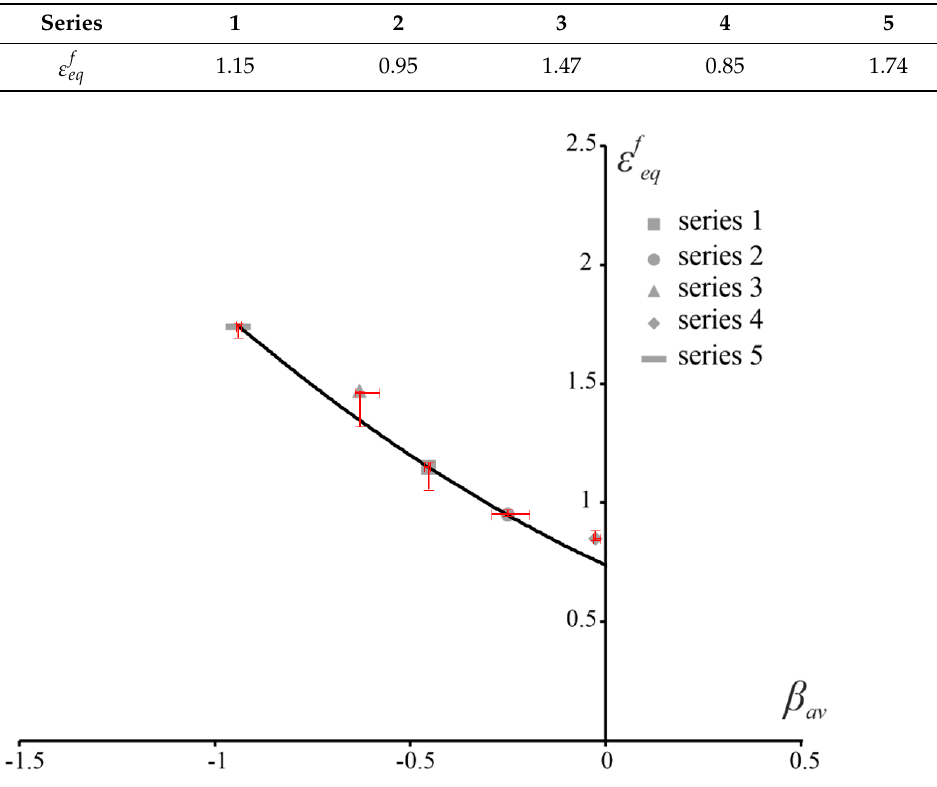
Table 5. Equivalent strain at the instant of fracture initiation.